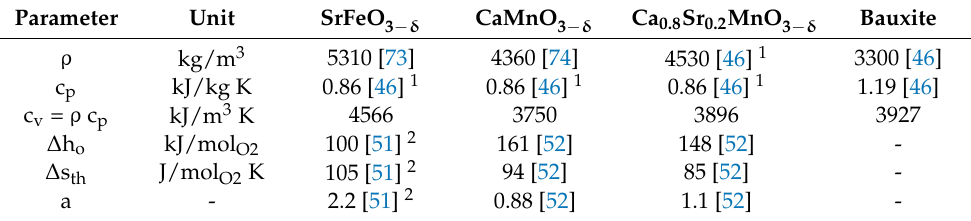
Table 1. Thermophysical and thermodynamic properties for selected perovskites and bauxite. Parameter